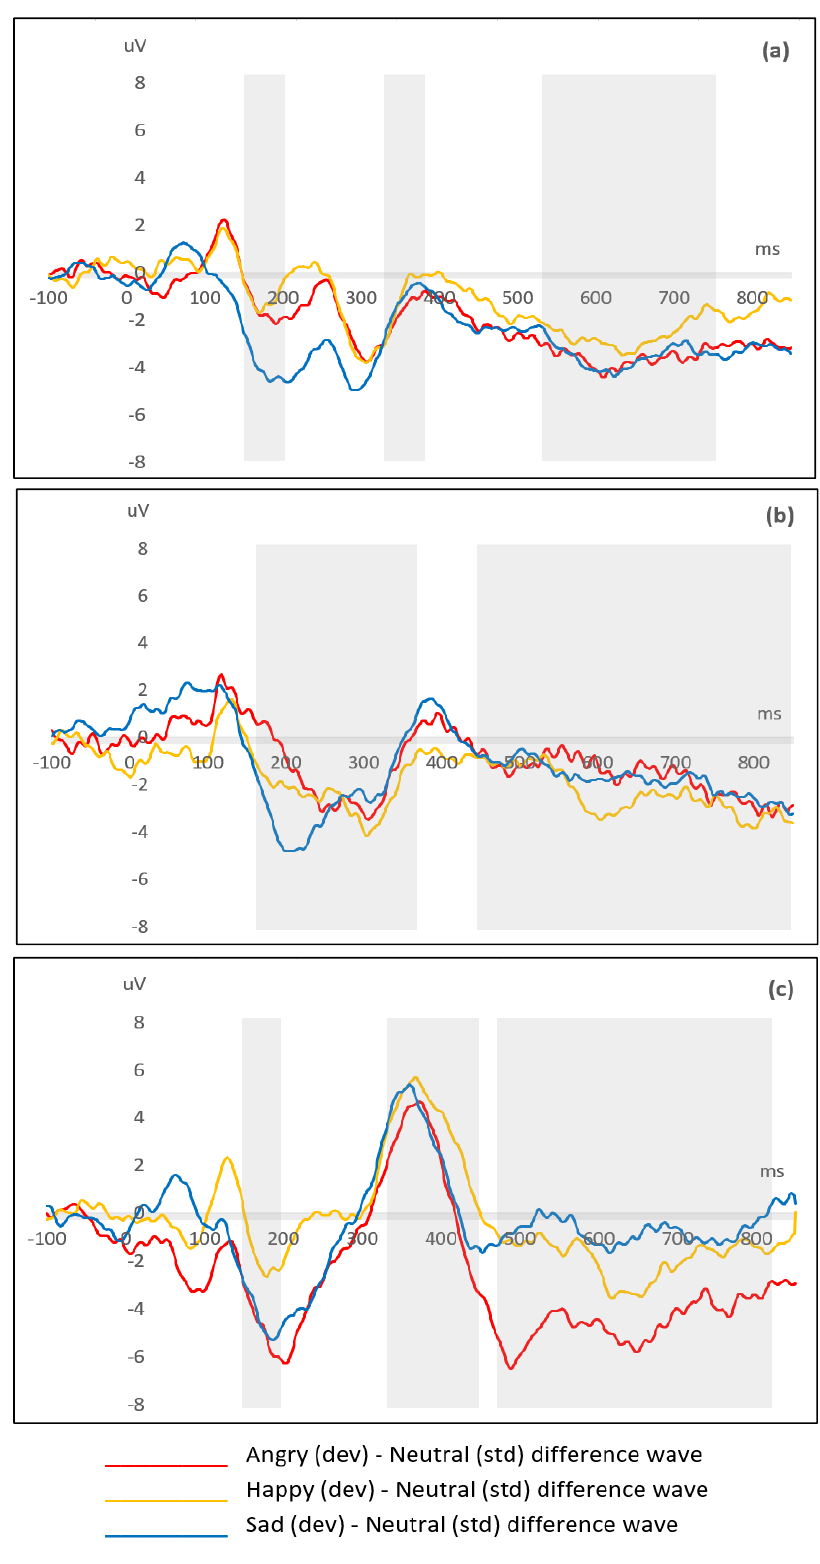
Figure 5. Separate emotion difference waveforms for ( a ) the TD group, ( b ) the ASD group pre- intervention, and ( c ) the ASD group post-intervention. Shaded regions depict the MMN, MMP, and LDN